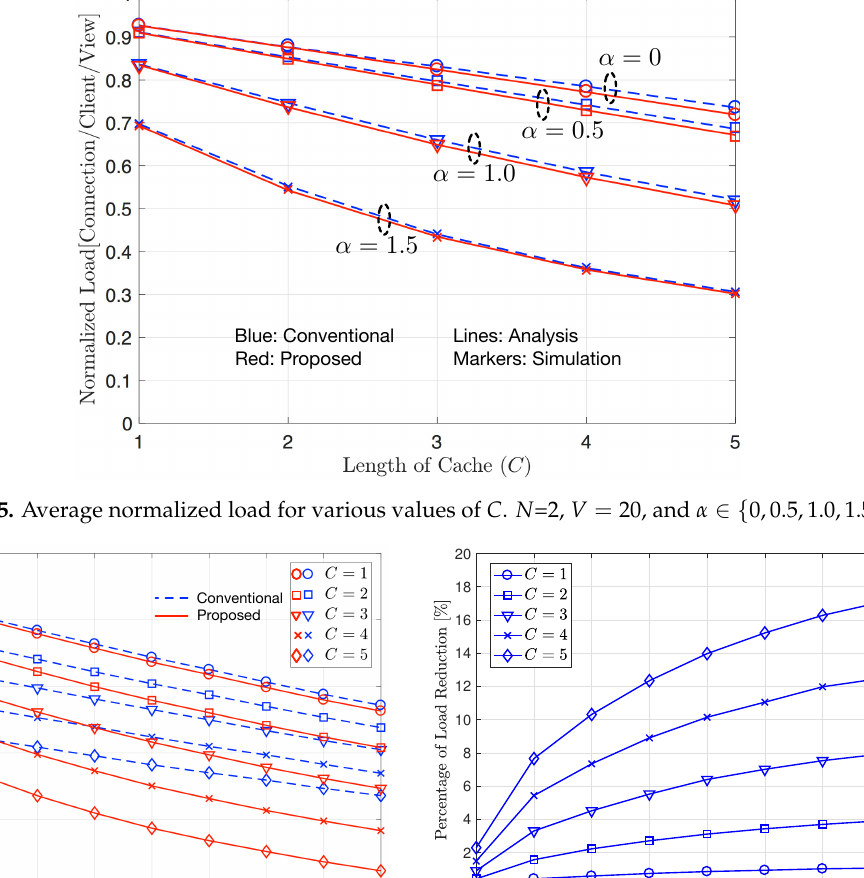
( a ) Average normalized load. Figure 6. Average normalized load and percentage of load reduction of the proposed scheme for varying N . V = 20, C 1,2,3,4,5 , and α = ∈ { }